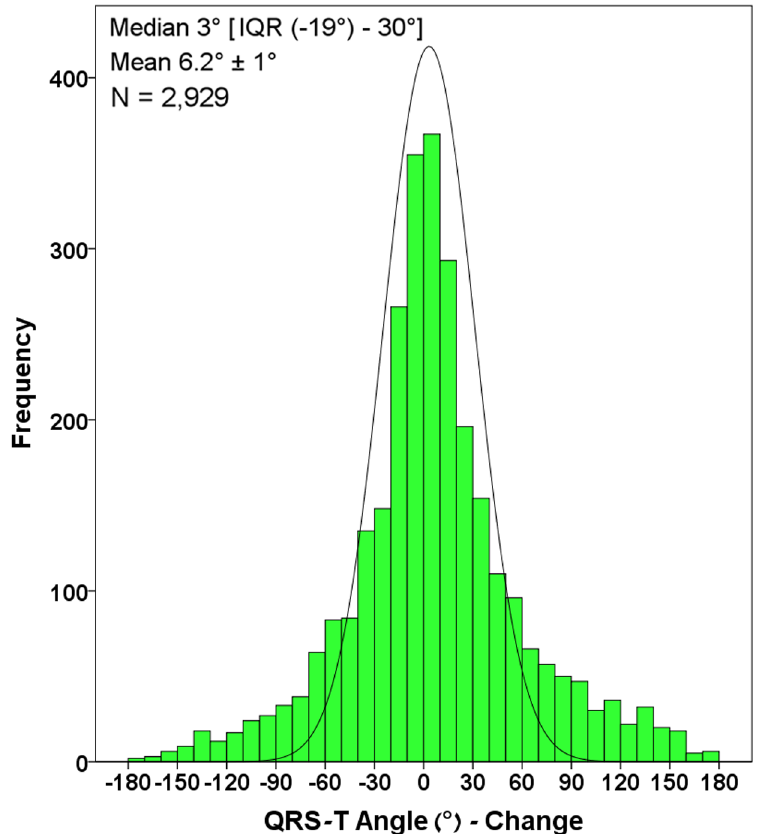
Fig 1. Changes in the QRS-T angle. Histogram of the QRS-T angle difference in degrees between baseline and follow- up ECG. The continuous line denotes the normal distribution curve.